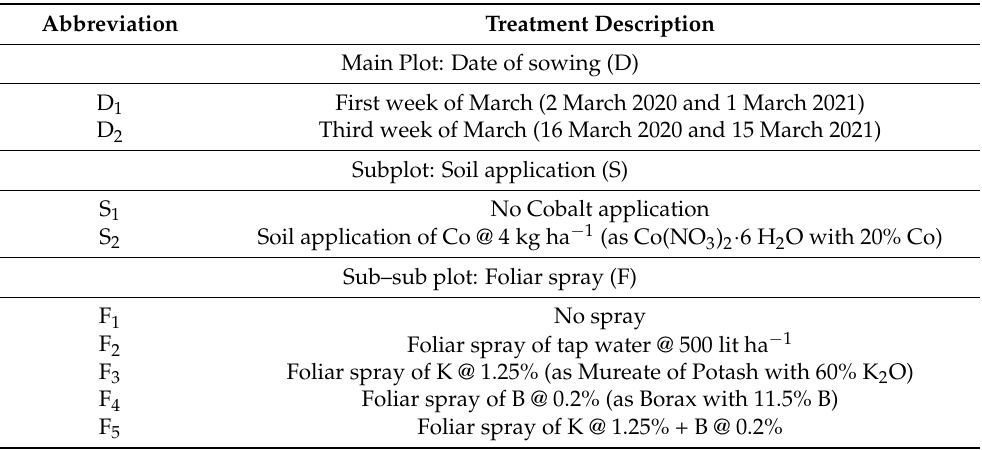
Table 2. Treatment details of the field experiment.